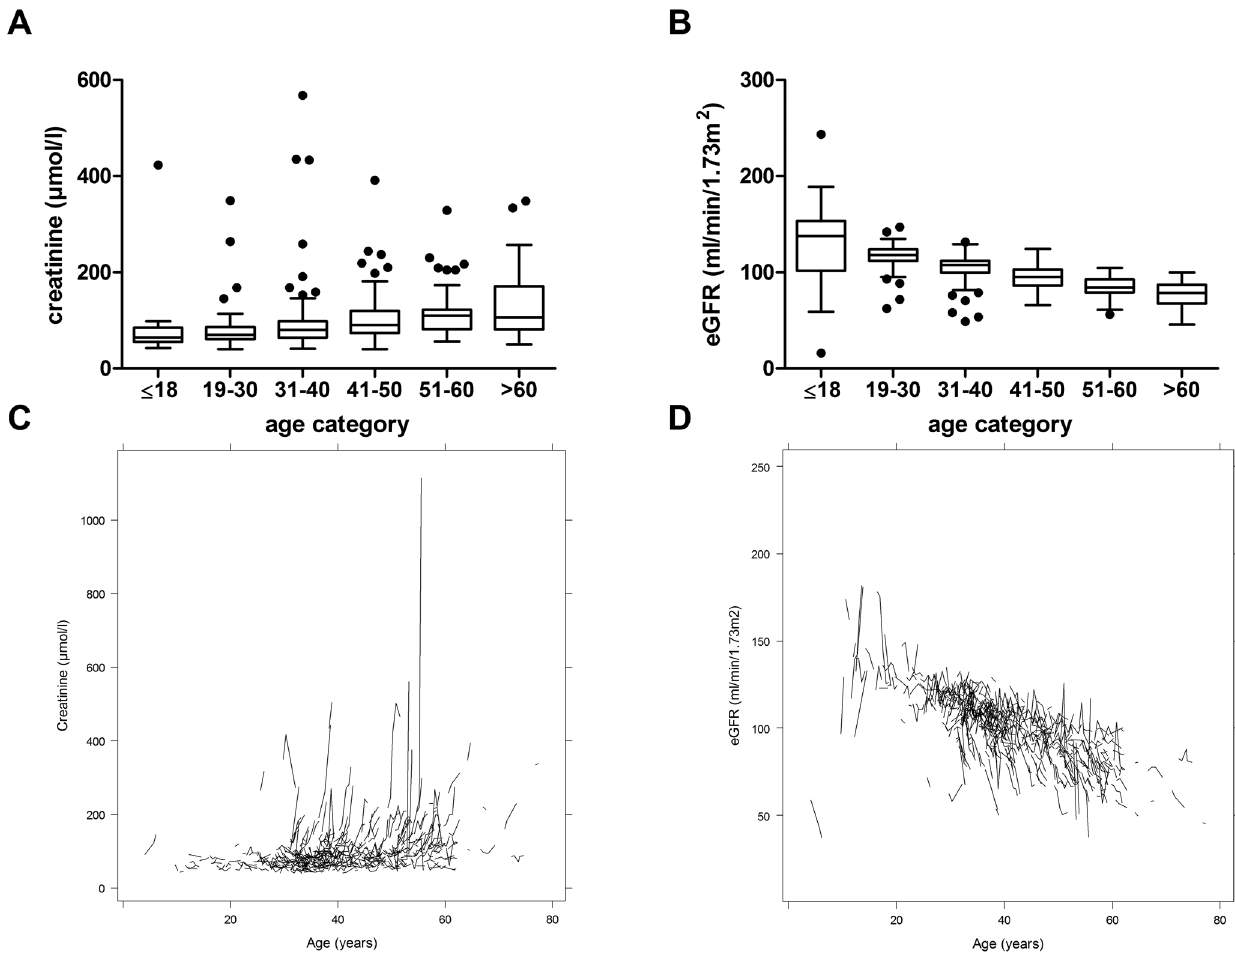
Figure 1. Renal function in different age categories of ADPKD patients . A) Creatinine ( m mol/l) for age categories # 18 years (n=20), 19–30 years (n=74), 31–40 years (n=171), 41–50 years (n=128), 51–60 years (n=90), and . 60 years (n=19). B) eGFR (ml/min/1.73 m 2 ) for age categories # 18 years (n=20), 19–30 years (n=74), 31–40 years (n=171), 41–50 years (n=128), 51–60 years (n=90), and . 60 years (n=19). Boxes show the median and the 25 th and 75 th percentile. Whiskers extend to the farthest points that are not outliers (i.e., that are within 3/2 times the interquartile range) and dots indicate outliers. C) Spaghetti plots for course of creatinine and D) eGFR over entire observation time in individual patients.